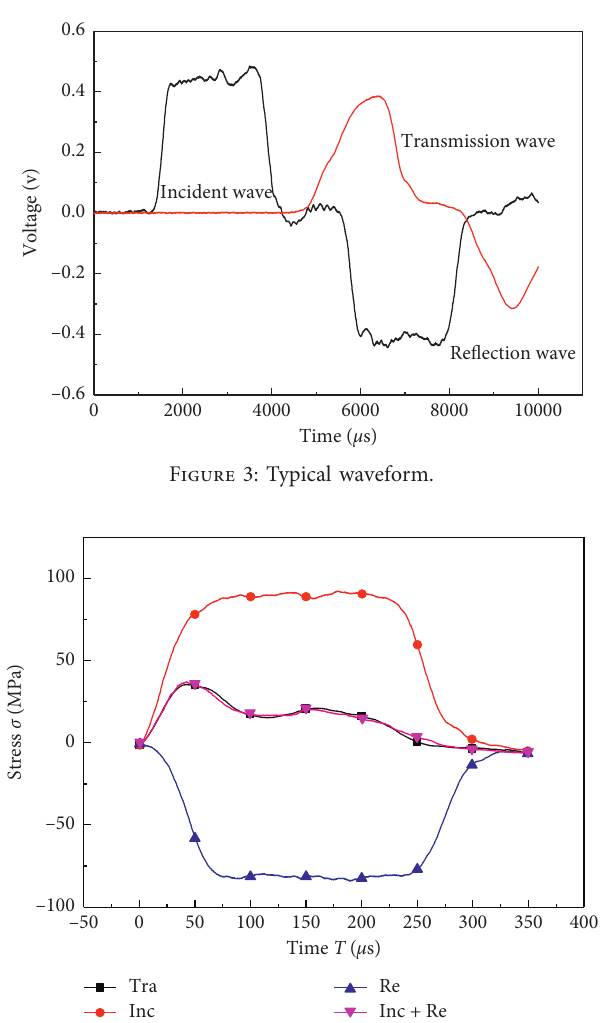
Figure 4: Typical dynamic stress equilibrium waveform.